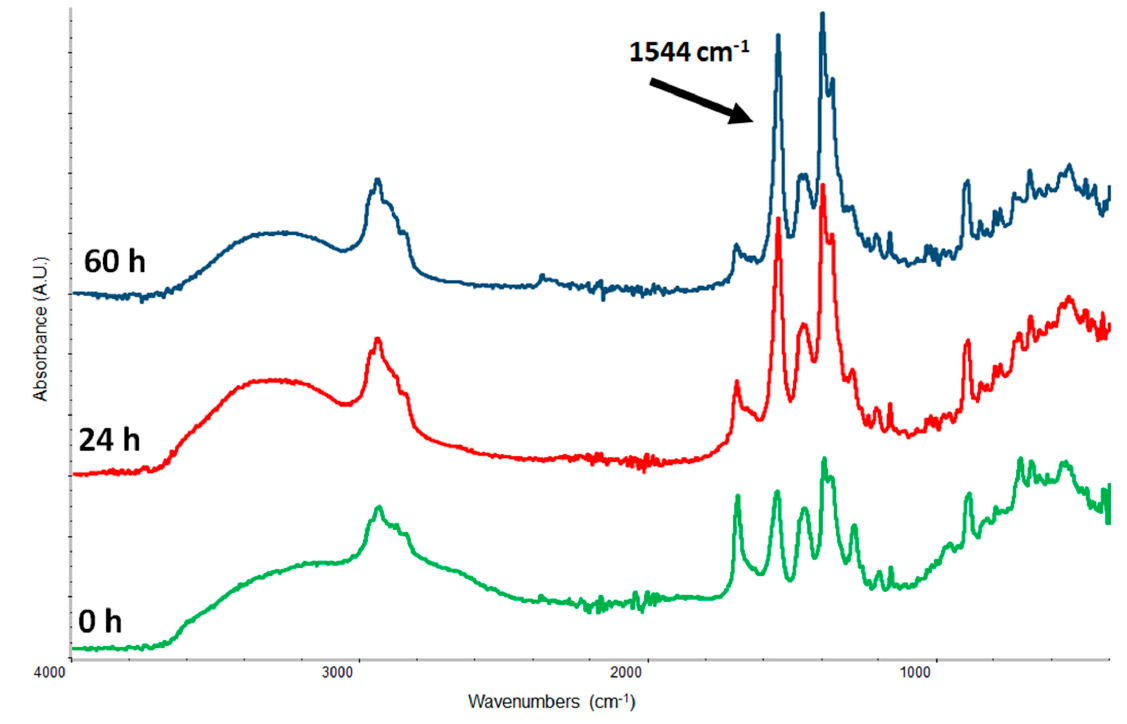
Figure 4. Kinetics of potassium carboxylate formation from a mixture 1:1 ( w / w ) of abietic acid and KOH. The black arrow shows the carboxylate band centered at 1544 cm − 1 .